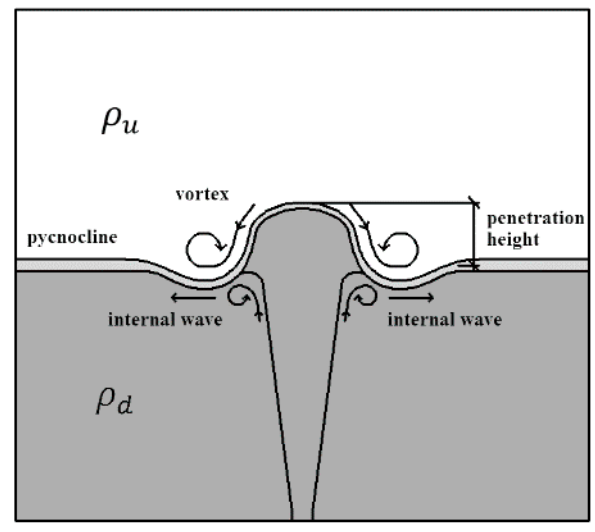
Figure 1. Schematic diagram of the jet interact with pycnocline.